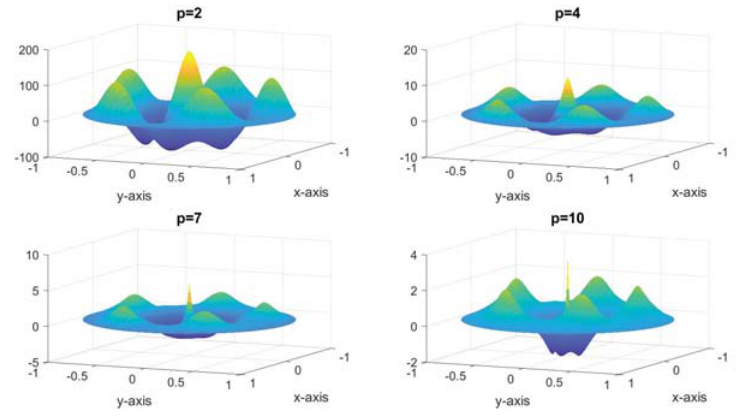
Fig. 8: Numerical solutions with three nodal regions and 5-symmetry